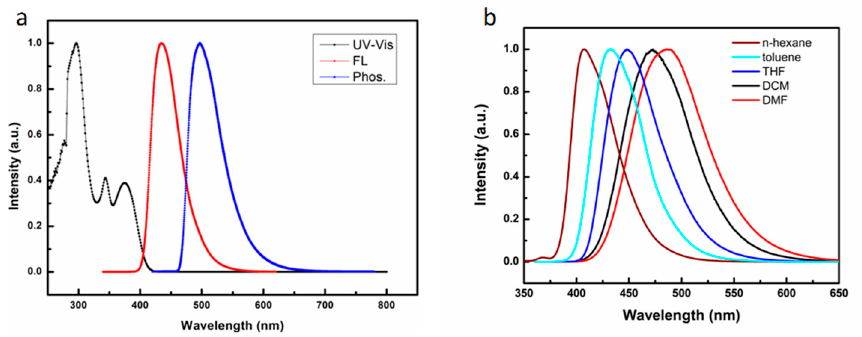
Table 1. Photophysical, thermal properties, and HOMO/LUMO energy levels of BCz–BFPz. Abs a BCz–BFPz a Measured in toluene solution at room temperature. b Measured in toluene solution at room temperature. c T d : Decomposition temperature. d E g : Band gap energy was calculated from the corresponding absorption onset in toluene solution. e E t : The triplet energy was calculated from the